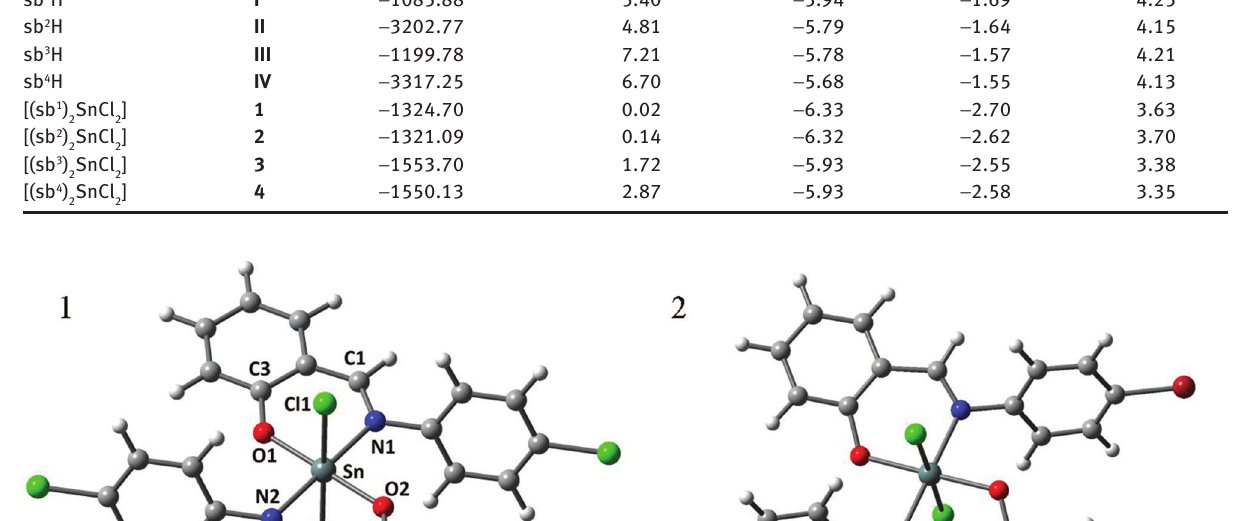
Table 1: Computed electronic properties for ligands ( I-IV ) and complexes ( 1-4 ). Compounds Total Energy (in au) Dipole Moment